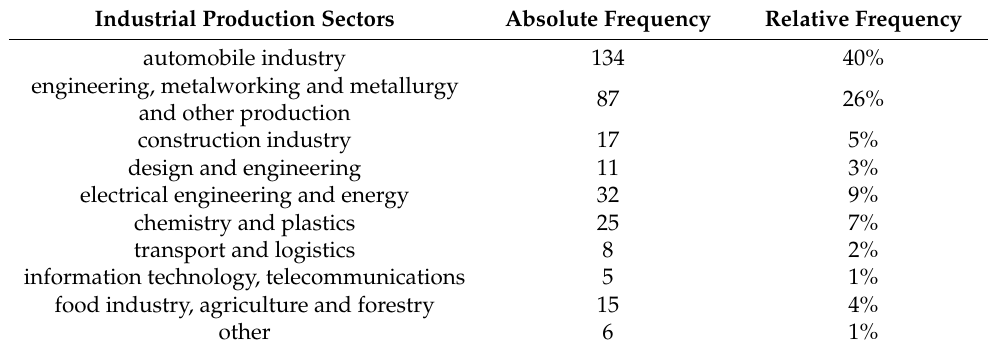
Table 1. Individual sectors of industrial